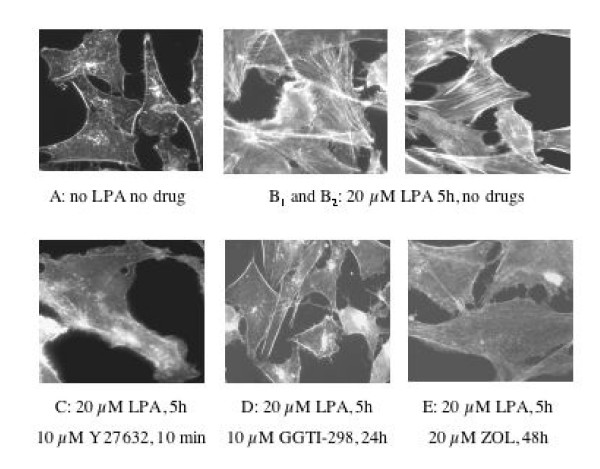
Effect of zoledronate on LPA-induced stress fiber induction, a cellular effect dependent on RhoA geranylgeranylation. On D0, PNT1-A cells were seeded onto glass coverslips in 6-well plates to obtain 60% confluence on D3. On D1, the cells were serum-starved till fixation on D3. After treatment by the indicated drugs then stimulation by LPA (20 μM, 5 hours on D3), actin fibers were visualized by tetramethylrhodamine isothiocyanate-labeled phalloidin. Cells are viewed on a Zeiss Axiophot microscope (X 630), and pictures are taken with a Princeton camera.